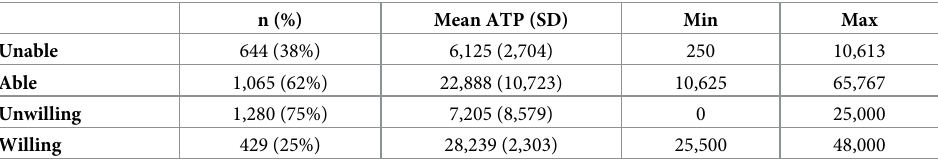
Table 6. Mean ATP for groups with ATP or WTP as their predominant constraining